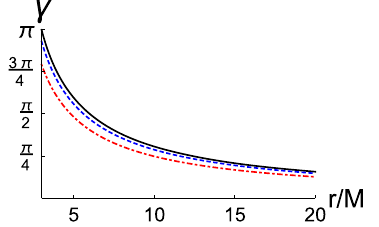
Fig. 2 The angle γ as a function of the radial distance r / r S for four kinds of observers. The black line, blue dashed line, red dot dashed line, andpurpledotdashedlinecorrespondtothestaticobserver,surrounding observer, freely falling observer, and escaping observer, respectively. The parameter r B is set to r B = 0 . 5 r S